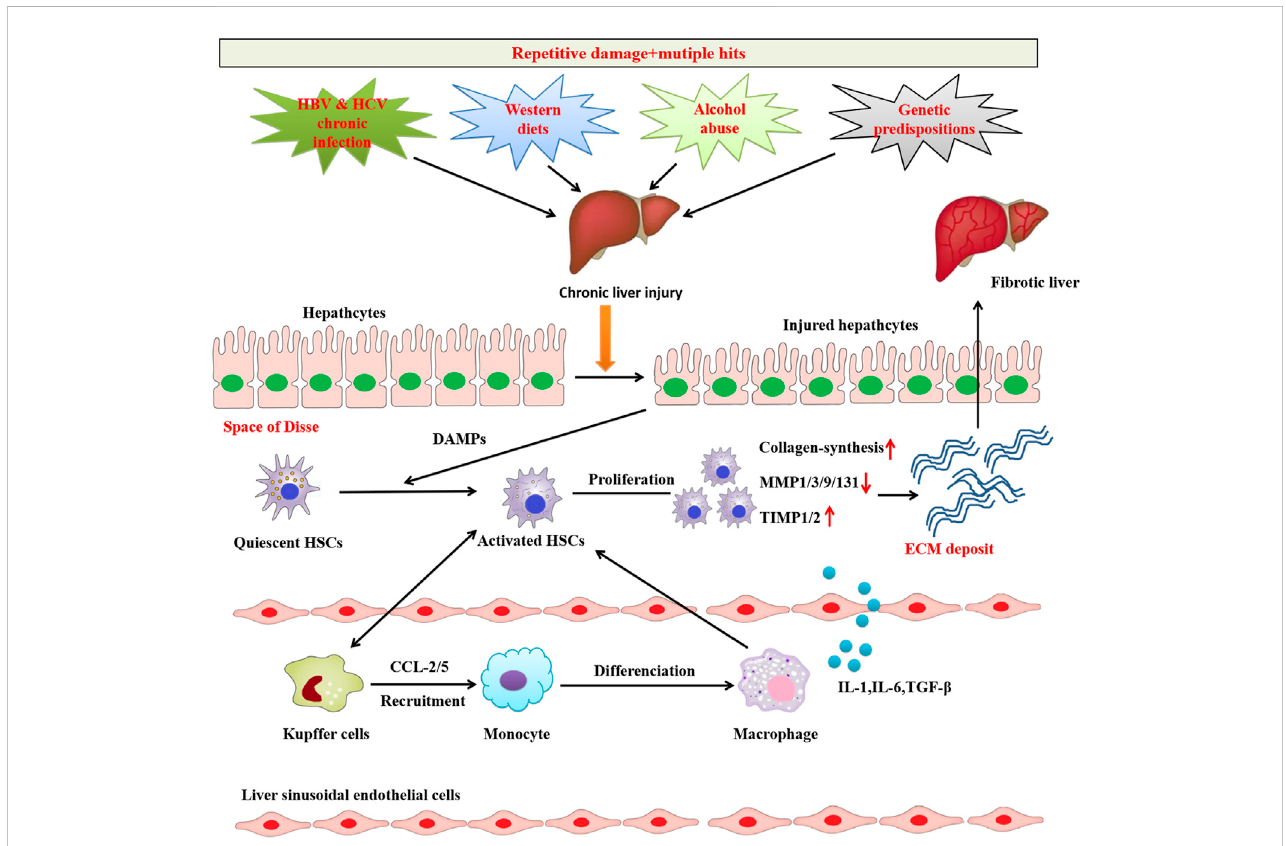
FIGURE 1 Common mechanisms of liver fi brosis. Repetitive damage and mutiple hits causes chronic hepatocyte injury, which causes release of damage- associatedpatterns(DAMPs)thatactivateHepaticstellatecells(HSCs)andrecruitimmunecells.Activated HSCsarecontinuouslyactivatedandproliferatedto secret abundant fi brogenic cytokines and produce excessive ECM, which causes the imbalance of pro- fi brosis/anti- fi brosismechanism.The pro- fi brosis mechanism leads to the abnormal formation of scar and eventually induces liver fi